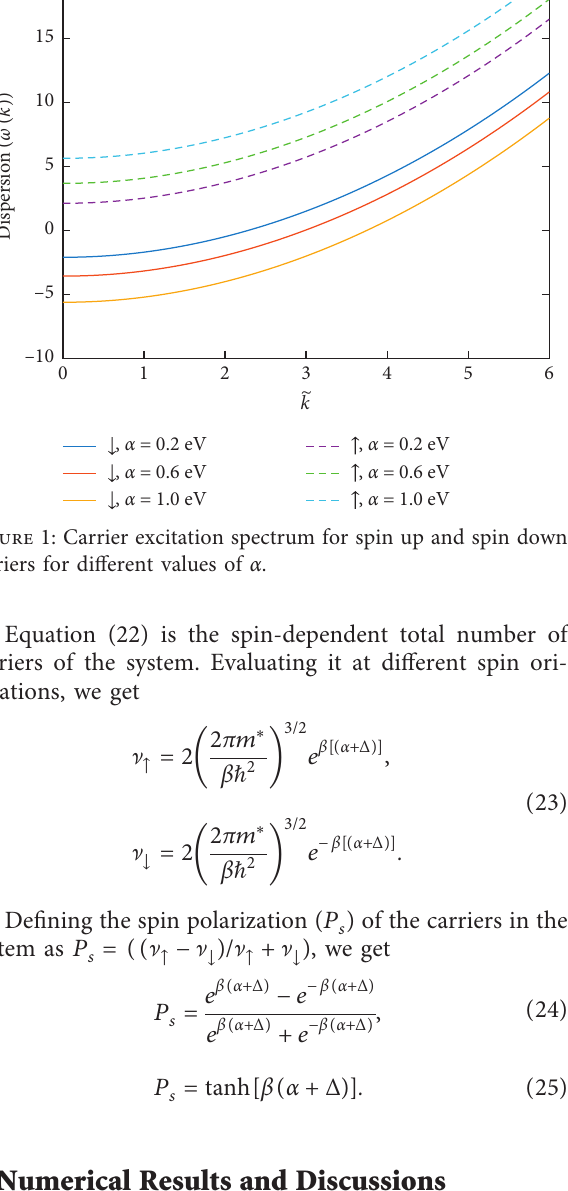
Figure 3: Electric field dependence of carrier spin polarization for T � 40K , 50K and